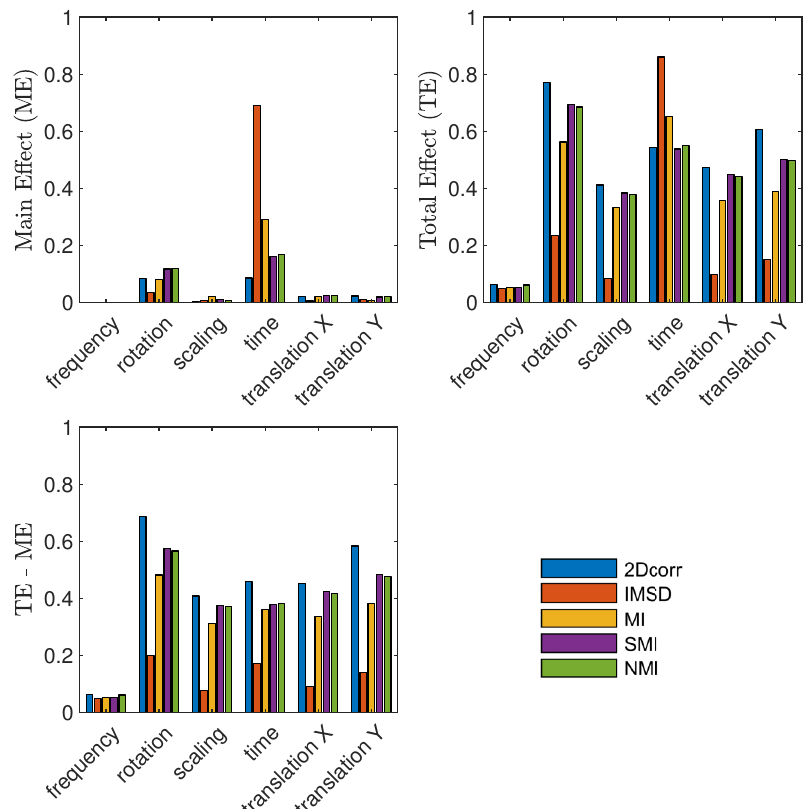
Figure 5. Global sensitivity indices of image similarity metrics to the six considered parameters, averaged overscenarios1, 2, 4and5. IndividualresultsforeachscenariocanbeconsultedinSupplementaryMaterials.